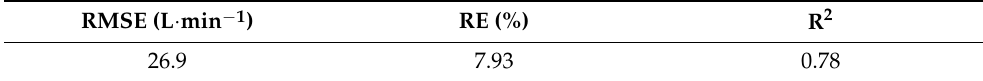
Figure 6. Adjustment of the simulated discharge to measured discharge with the calibrated model. Table 4. Goodness of fit of the calibrated model for the discharge.